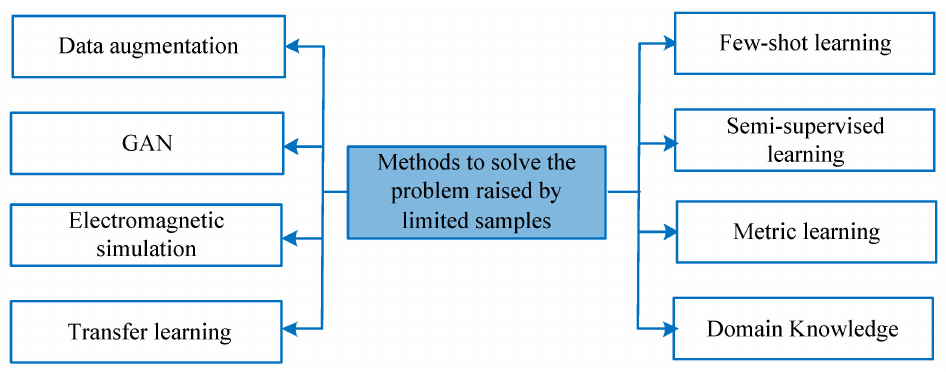
Figure 11. Methods to solve the problem raised by limited samples.